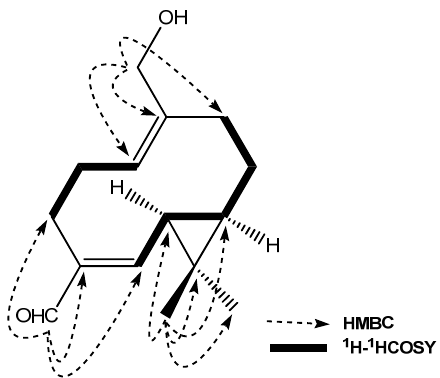
Figure 1. The correlations of structures, 1 H- 1 H COSY and Key HMBC of 1 .